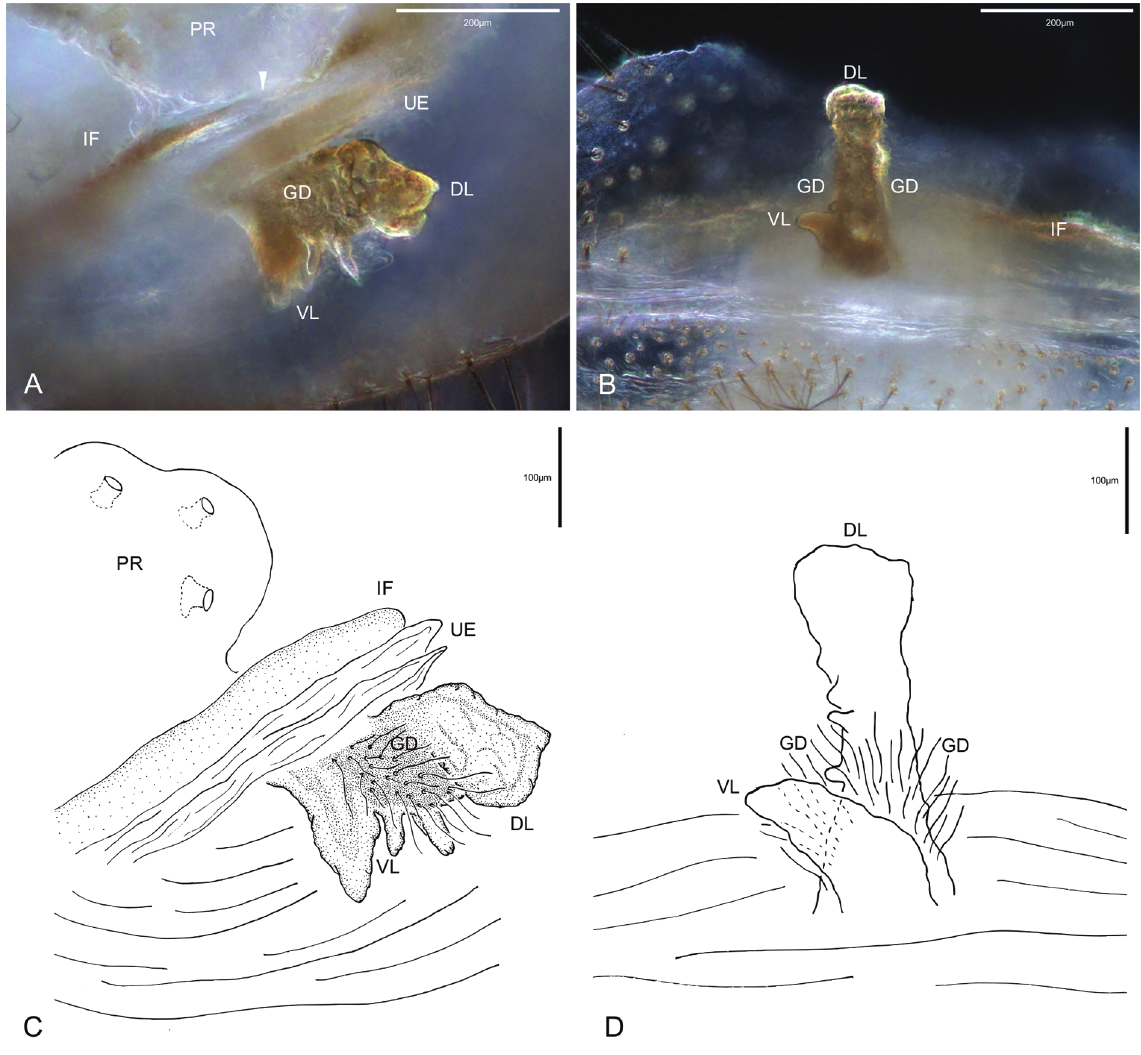
Fig. 3. Ariadna motumotirohiva sp. nov., ♀, paratype (IBSP 246895). A–D . Internal genitalia. A , C . Lateral view, arrowhead in A = median membranous crack. B , D . Detail of the anterior recep- taculum, ventral